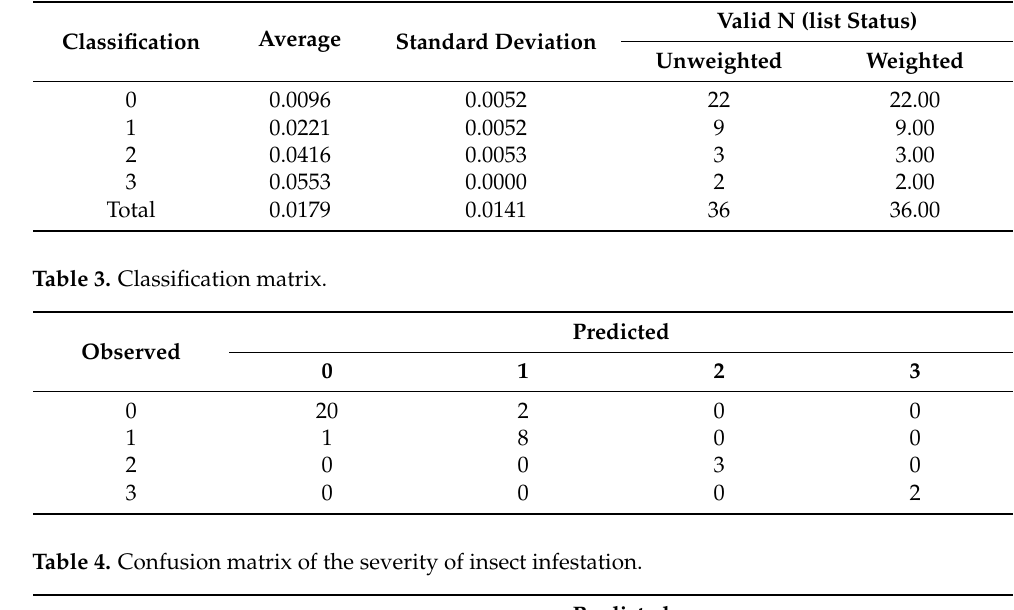
Table 2. Class statistics.